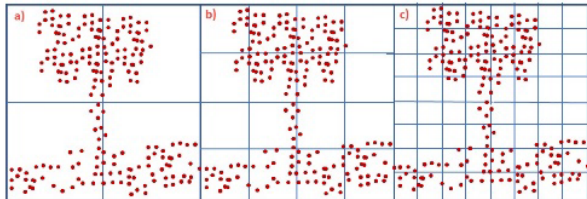
Figure 8: A point cloud in voxel grids with different resolutions